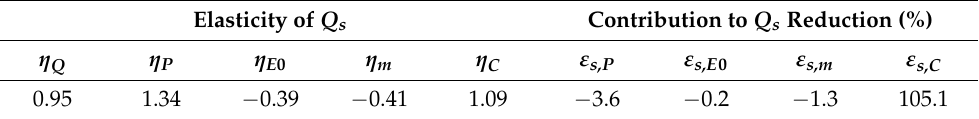
Table 4. Elasticity of suspended sediment load ( Qs ) and contribution to Qs reduction with respect to precipitation ( P ), potential evapotranspiration ( E 0), sediment concentration ( C ), and catchment property ( m ).